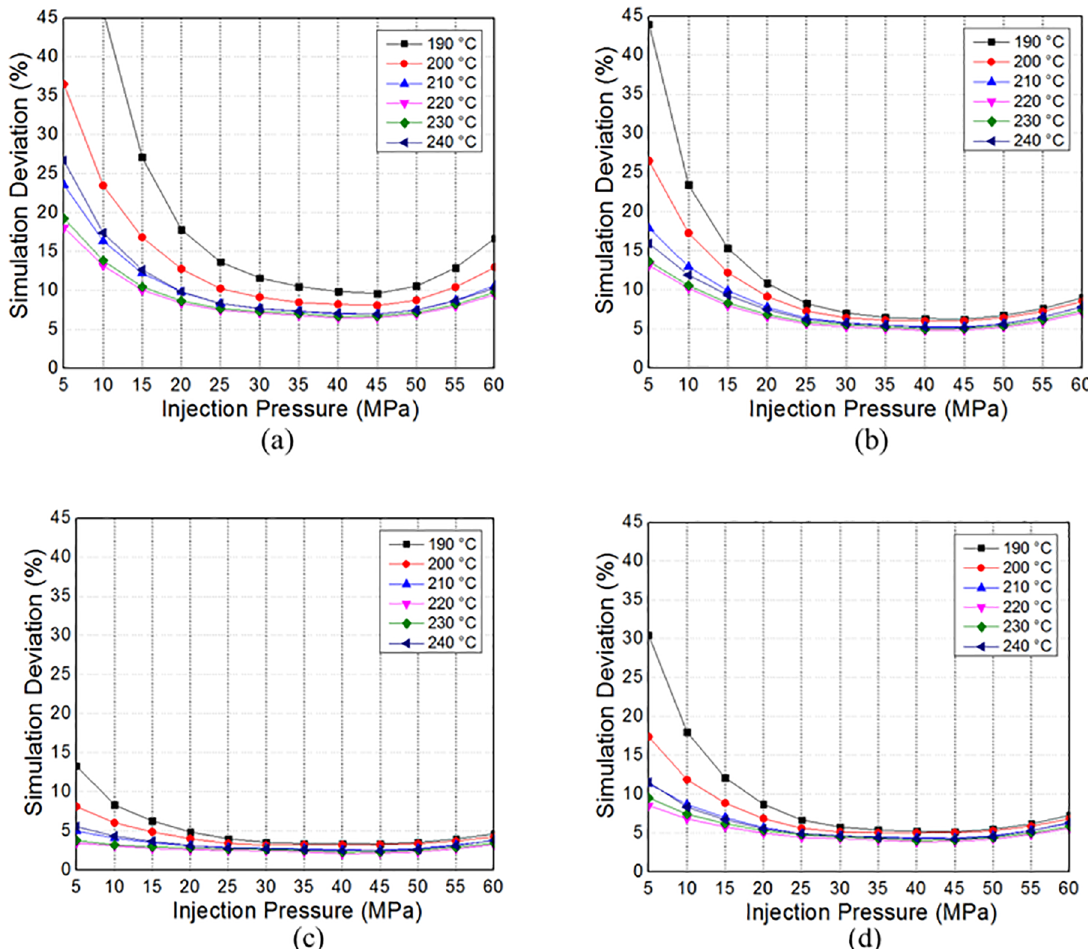
Figure 9. Simulation deviations considering the original mold varying the injection pressure and temperature for distinct situations of mold temperatures: a) 20 ºC; b) 30 ºC; c) 40 ºC; d) 50 ºC.